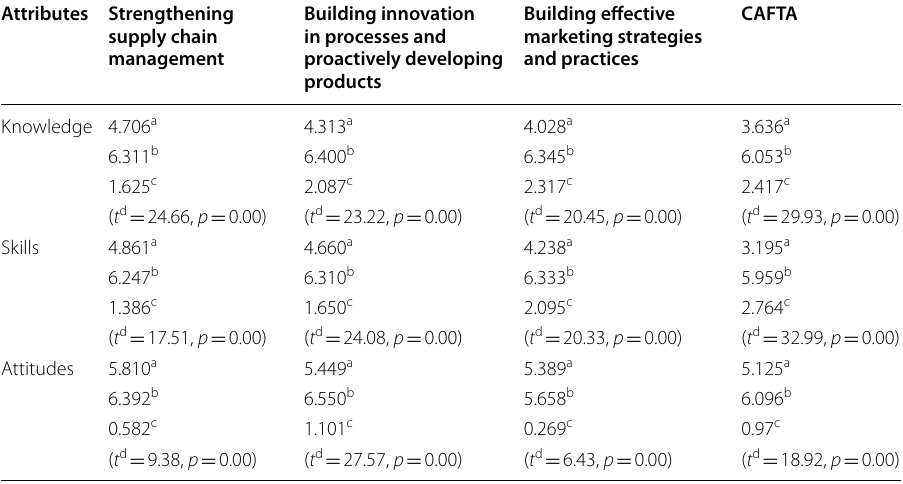
Table 3 Mean differences in workshop participants’ learning outcomes: before and after